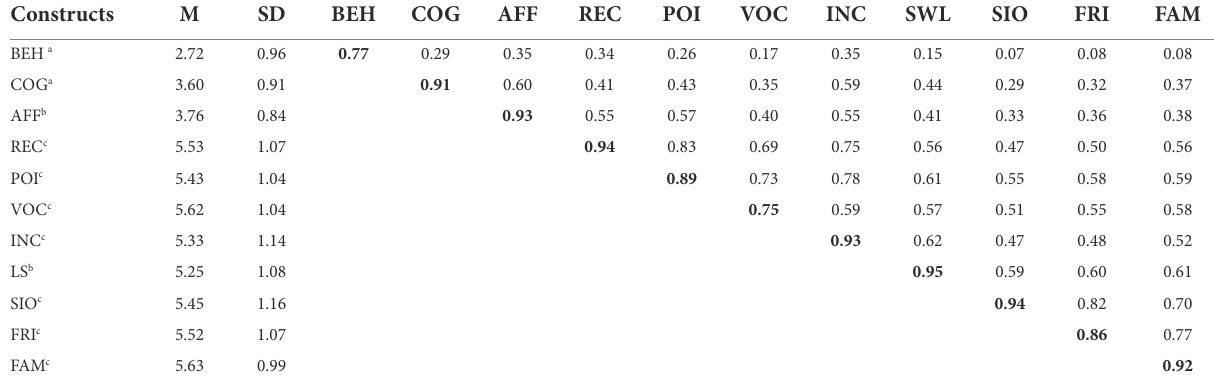
TABLE 3 Descriptive statistics and discriminant validity.